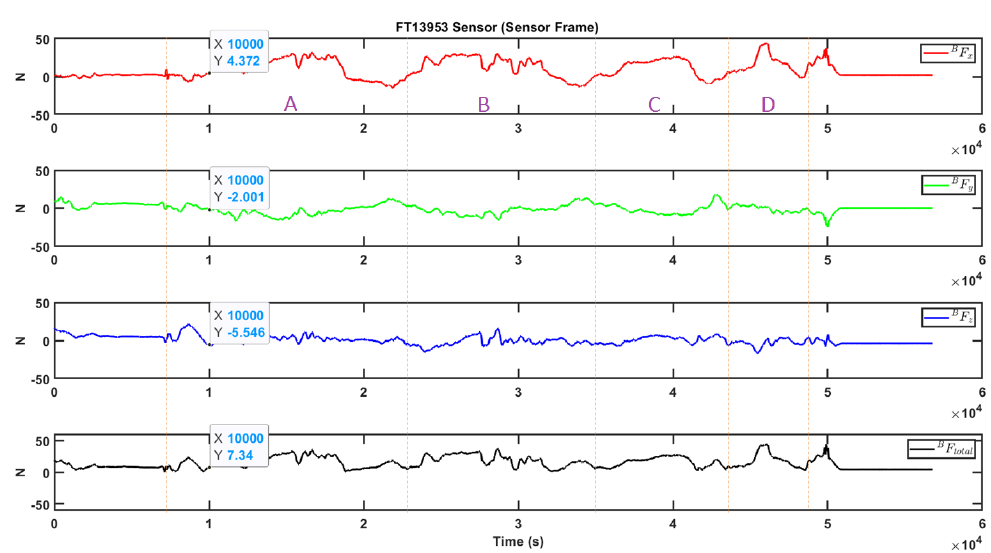
Figure 18. Forces applied by the user in Experiment